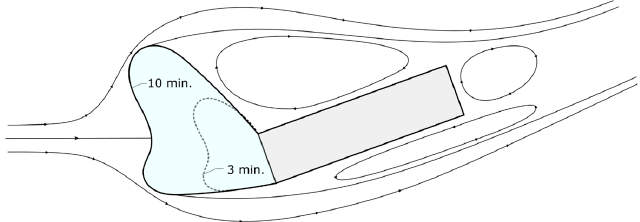
Figure 8. Sketch of air pathlines over a rectangular body after 3 and 10 min of icing. Bluish area: Sketch of accreted ice.